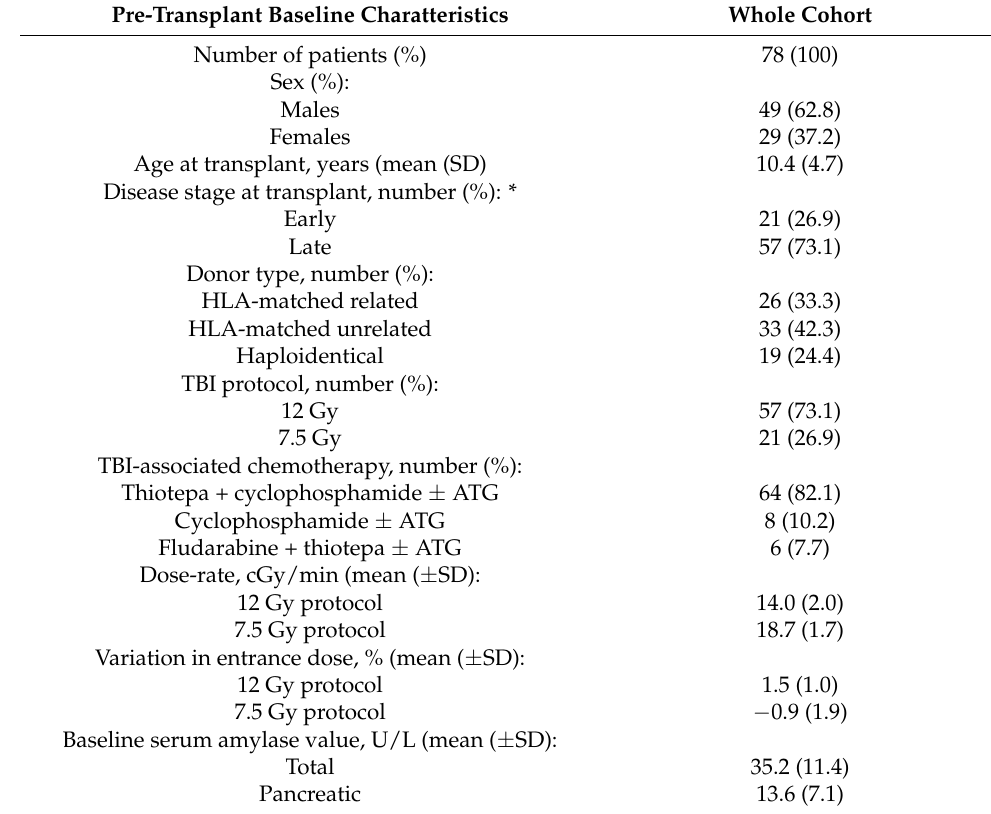
Table 1. Characteristics of the ALL patients at